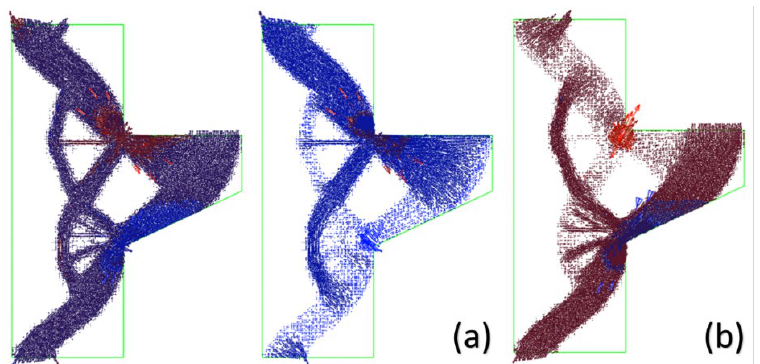
Figure 16. Principal stress trajectories for f = 50% (a: tension; b: compression)